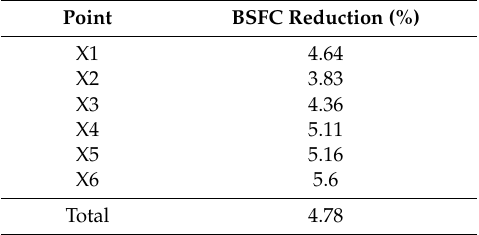
Figure 13. Reduction of BSFC in ORC system. Table 4. Maximum BSFC reduction in ORC system.